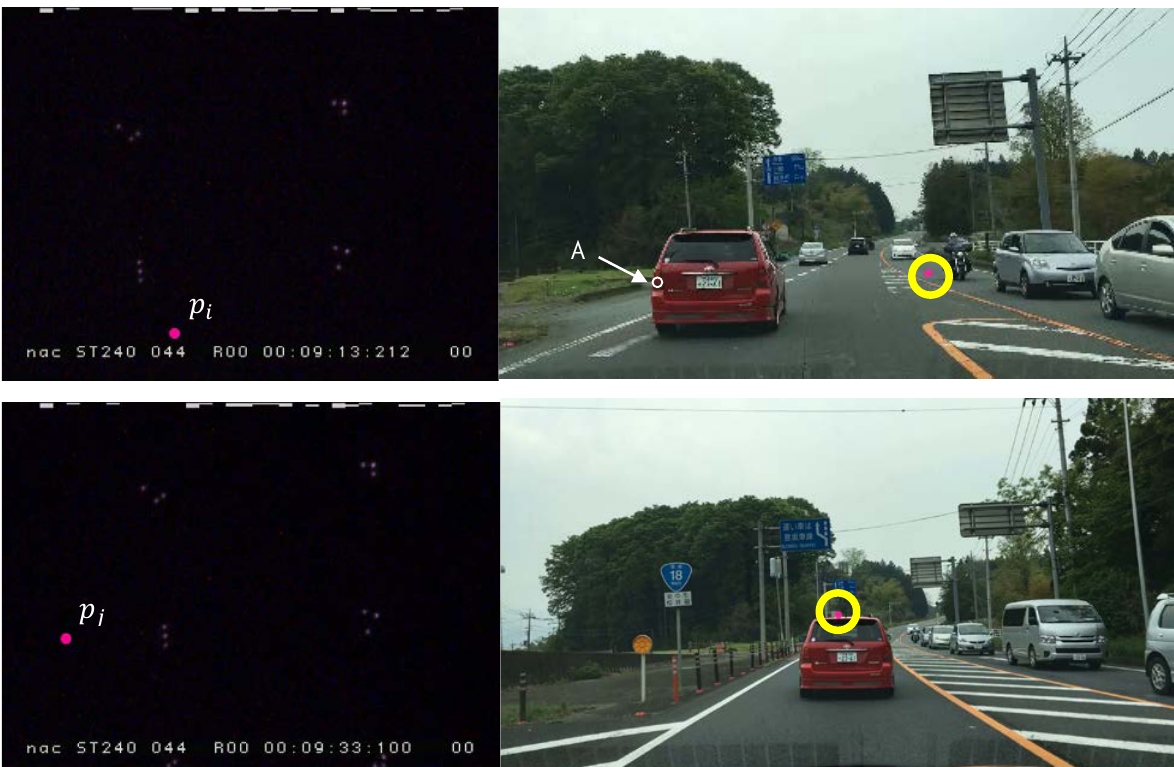
Figure 17: Examples of the images of filtered view camera (left; pink dots: eye positions) and the corresponding corrected eye position mapped on the video footage (right; corrected eye positions are